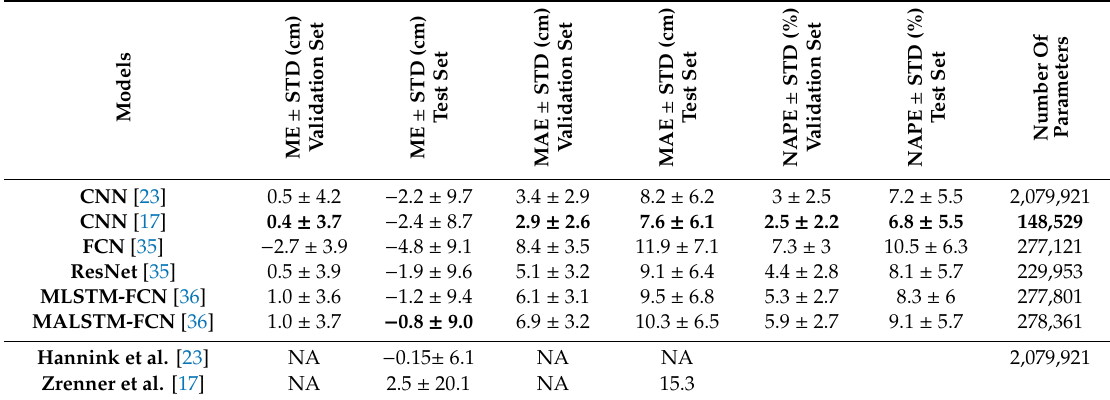
Table 4. Stride length prediction errors, mean error (ME), mean absolute error (MAE), and normalized absolute percentage error (NAPE) for multiple contemporary network